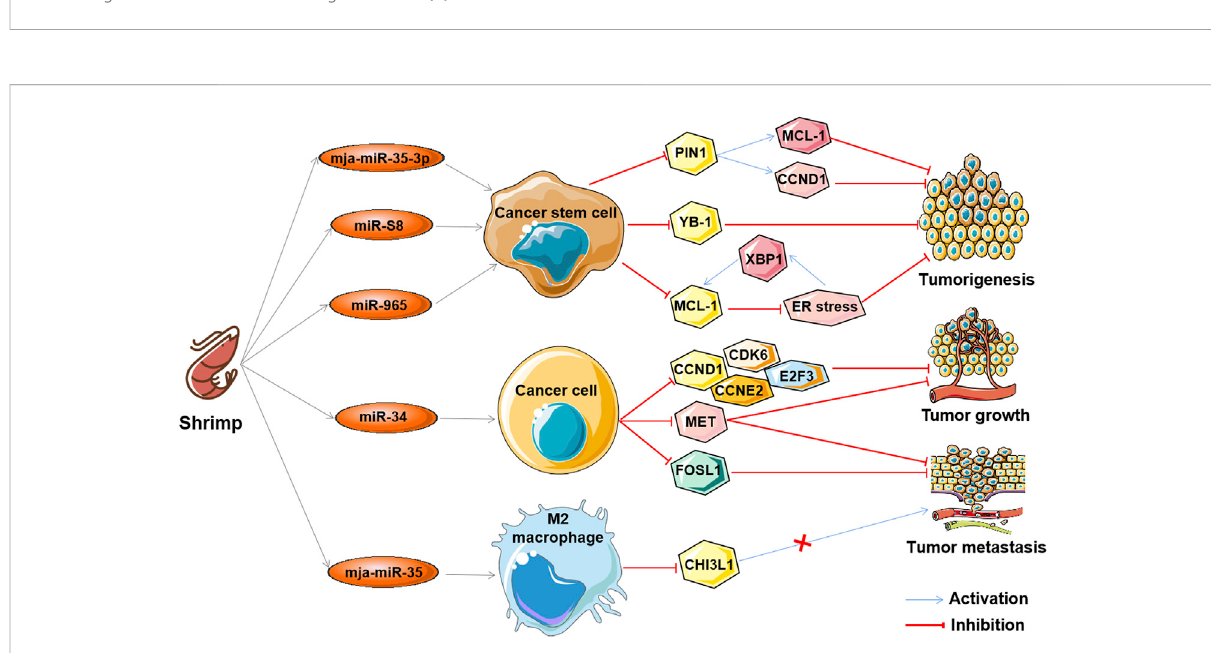
FIGURE 4 Marine-derived antitumor agent-related non-coding RNAs in tumor cell drug sensitivity and resistance. Non-coding RNAs (ncRNAs) regulated by marine-derived antitumor agents (cytarabine or trabectedin) can be used as tumor suppressors to induce the drug sensitivity of tumor cells (A) or as oncogenes to induce cellular drug resistance (B) .